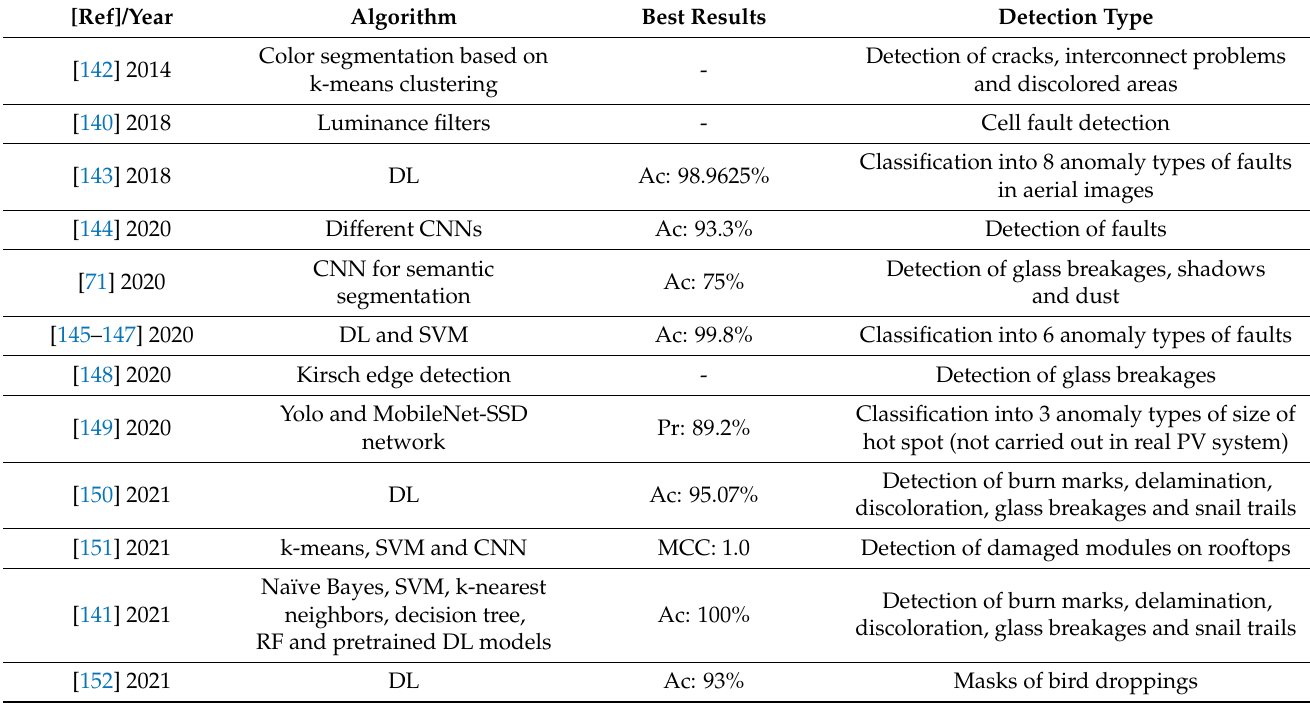
Table 5. Summary of methods for detecting and classifying faults in visual images of PV modules.